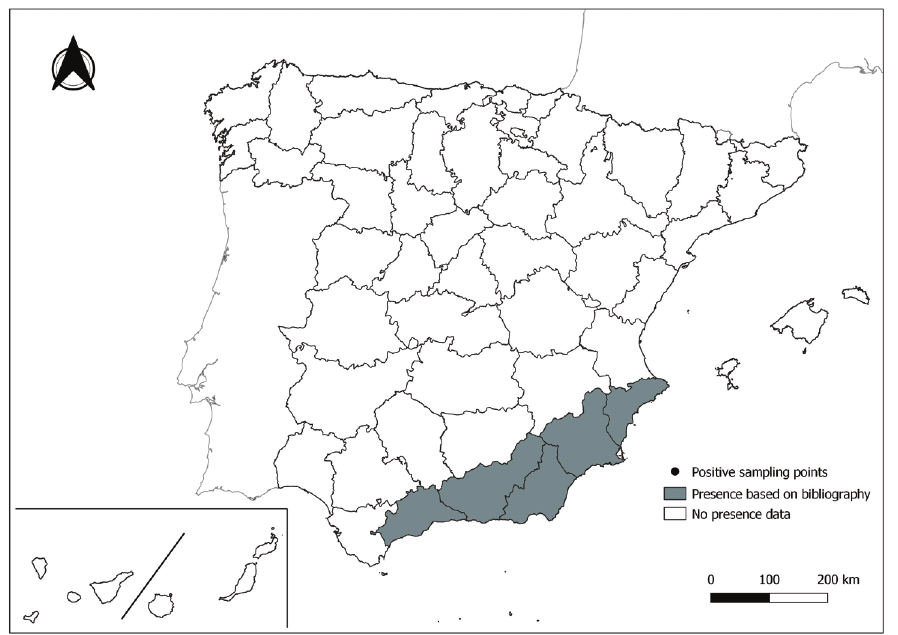
Figure 8. Distribution of Phlebotomus alexandri in